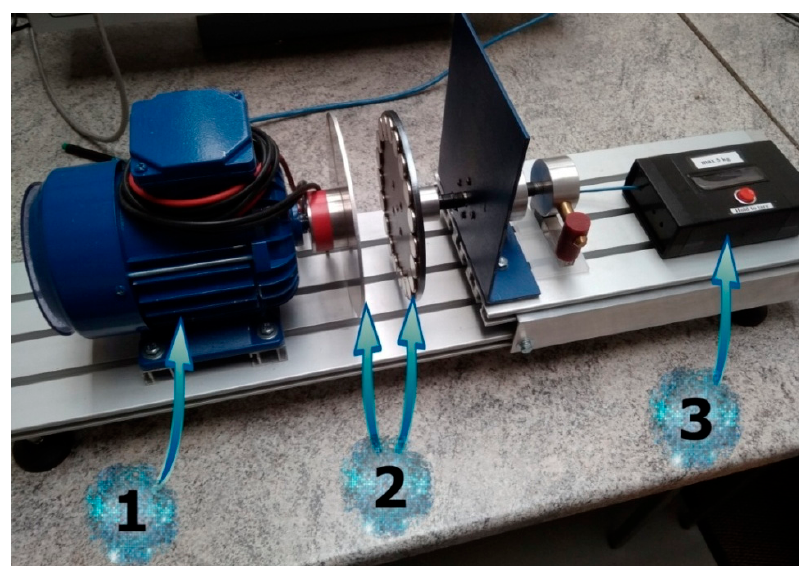
Figure 6. The lab test setup (1—LSPMSM prototype, 2—PM eddy current brake, 3—load measurement system).